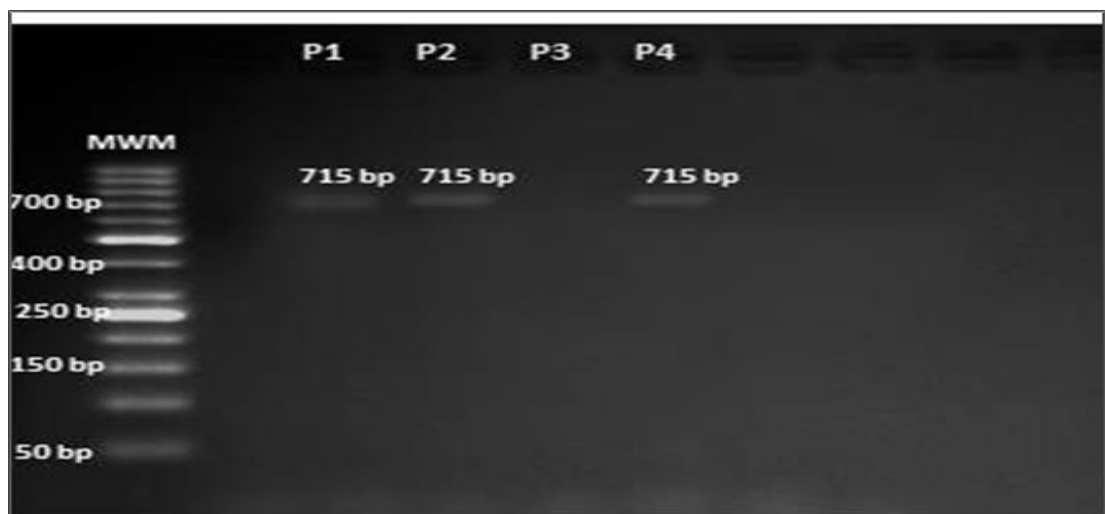
Figure 5. Agarose gel electrophoresis of PCRprod- ucts after amplification of mcr-1 gene. MWM- molecular weight marker (50 bp DNA ladder), P1, P2, P3, P4; P.aeruginosa positive for mcr-2 gene products (715